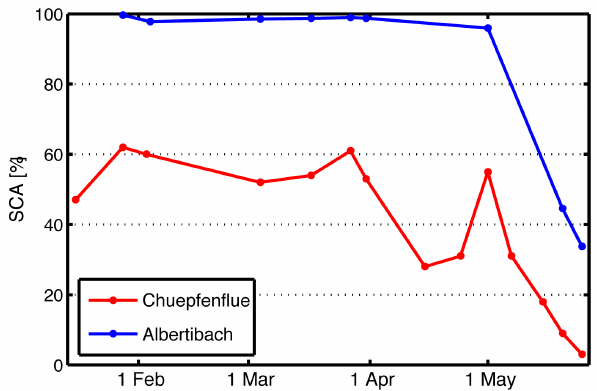
Fig. 4. Snow covered area (SCA) in the rock face Ch¨upfenflue and in the Albertibach catchment from 16 January to 25 May 2009. SCA was calculated for the entire base